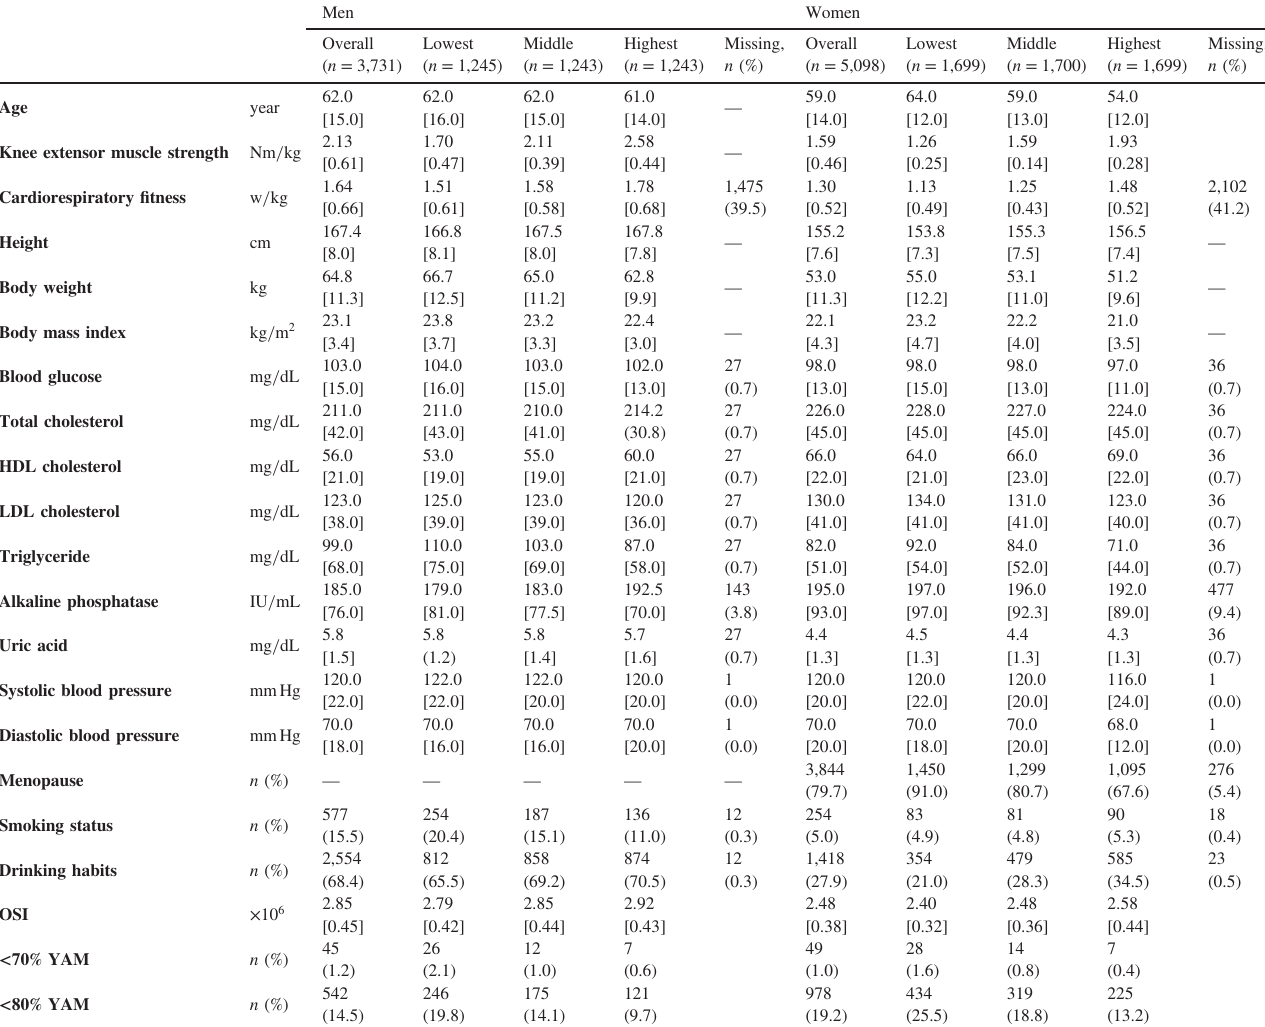
Table 1. Participant characteristics according to knee extensor muscle strength Men